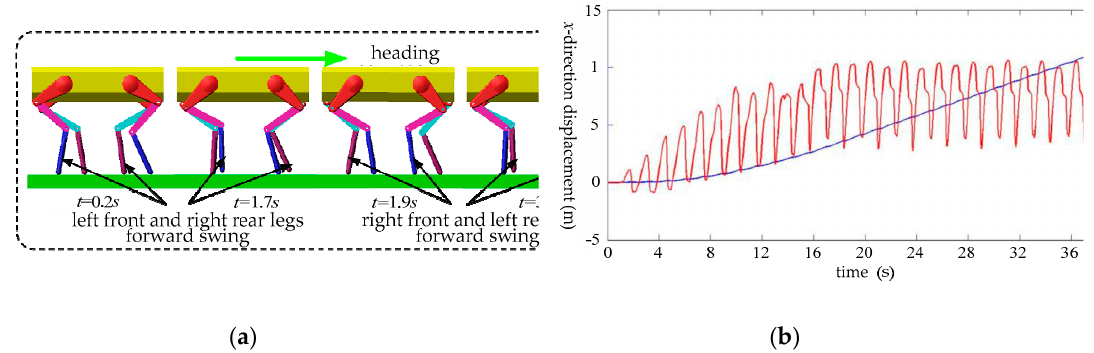
Figure 17. Simulation decomposition diagram of the trot gait of the simulation prototype. ( a ) Simulation diagram of trot gait. ( b ) The y-direction velocity and x-direction displacement curve of a quadruped robot.